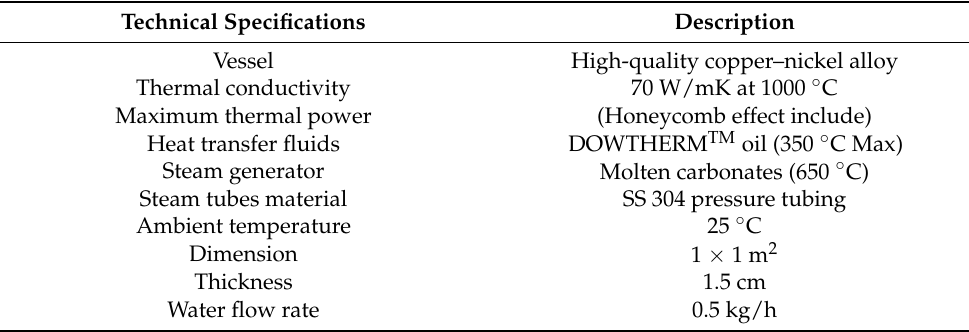
Figure 4. The proposed assembly of the steam generator and SOEC; inputs are desalinated water and electrical power from PV, outputs are hydrogen and oxygen; GaN honeycomb structure is present at the top of Tank 1 and Tank 2. Table 2. Proposed steam generator design